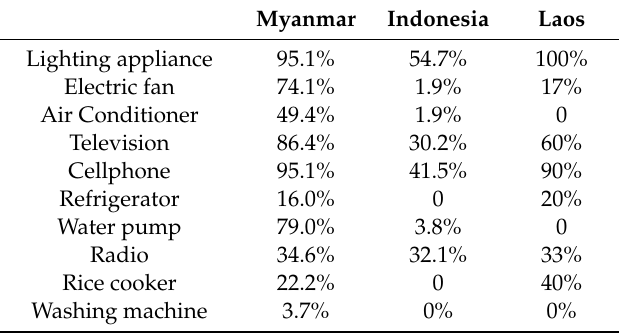
Table 4. Rate of appliance ownership in each case study village from the survey questionnaire.